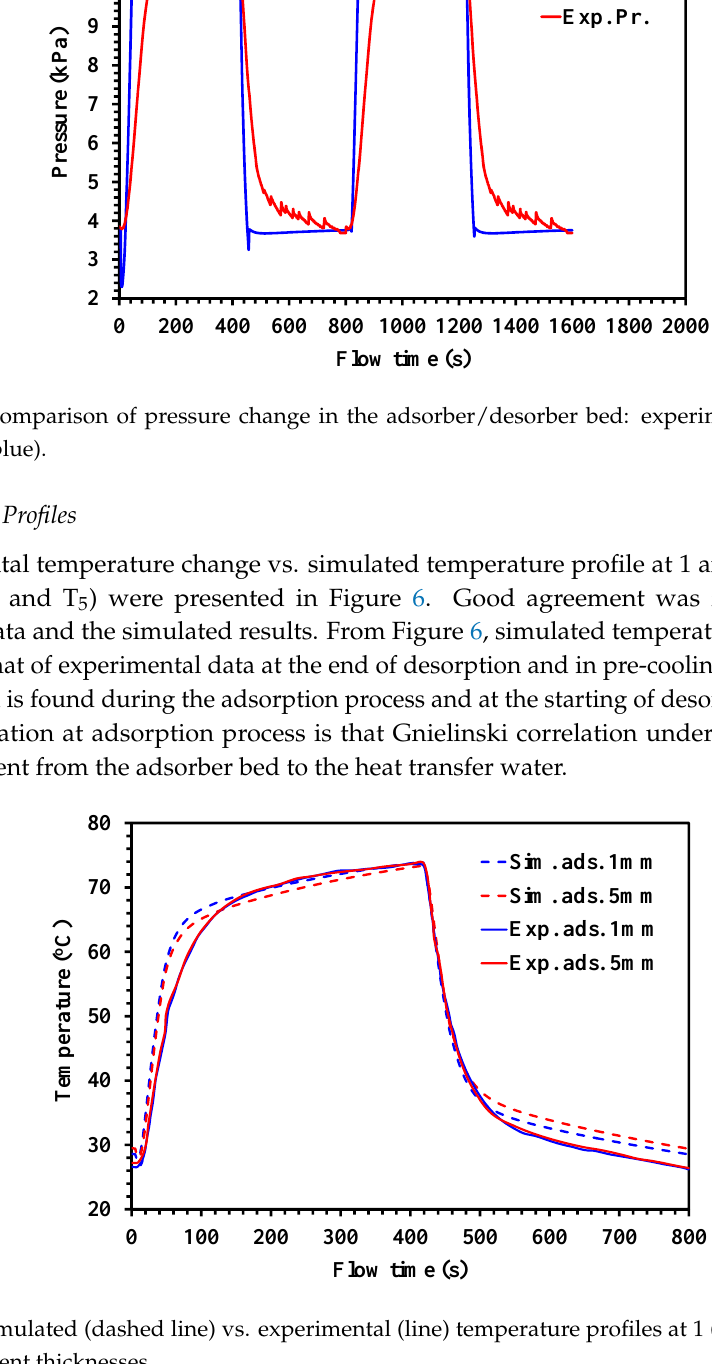
Figure 7. Simulated temperature profiles at different adsorbent thickness. 4.3. Adsorption Characteristics The profiles of equilibrium uptake ( (cid:1869) ∗ ) and instantaneous uptake ( (cid:1869) ) in the adsorber/desorber bed are displayed in Figure 8. The difference between maximum and minimum values of equilibrium uptake ∆(cid:1869) ∗ is 0.51 kg/kg whereas the change in case of instant uptake ∆(cid:1869) is 0.314 kg/kg. This means that ethanol adsorption onto activated carbon is only 61.6% of its capacity within the 400 s adsorption time.